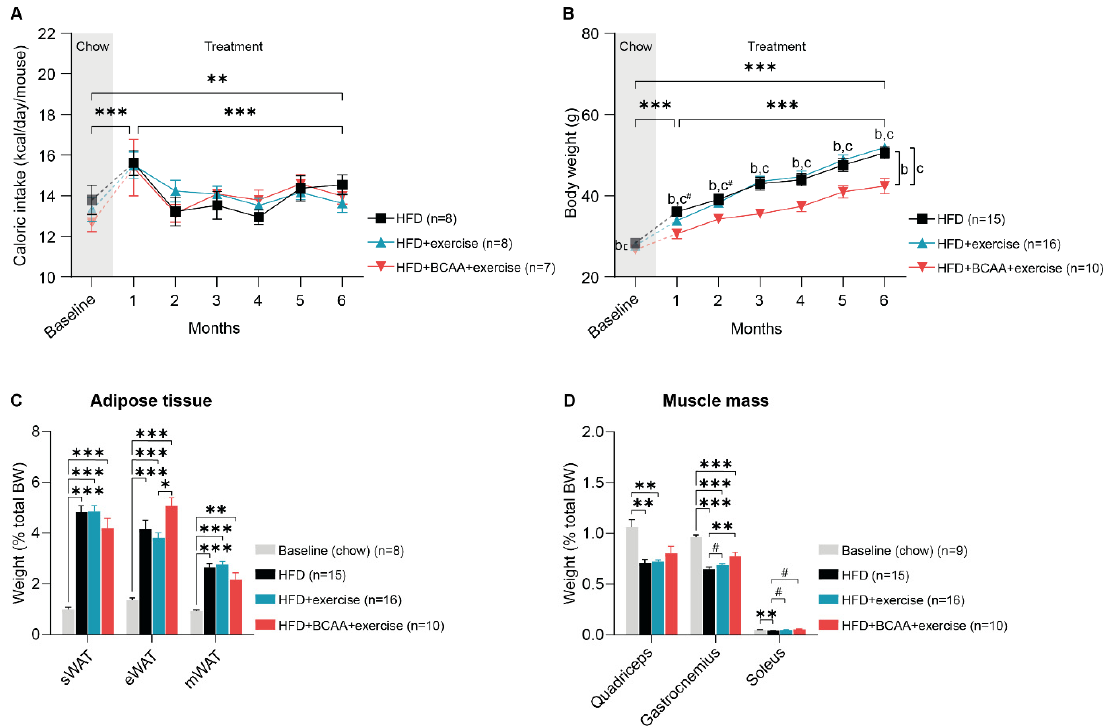
Figure 2. Body weight, caloric intake, fat depots, and muscle mass. The impact of exercise (HFD + exercise) and exercise combined with BCAA supplementation (HFD + BCAA + exercise) on ( A ) body weight, ( B ) caloric intake, ( C ) white adipose tissue depots (subcutaneous adipose tissue (sWAT), epididymal white adipose tissue (eWAT), and mesenteric white adipose tissue (mWAT)), and ( D ) muscle weight (quadriceps, gastrocnemius, and soleus) expressed as a percentage of total body weight (BW). High-fat diet (HFD), branched-chain amino acids (BCAA). Data are presented as mean ± SEM. * p < 0.05, ** p < 0.01, *** p < 0.001, # 0.05 < p < 0.08 (trend); b: significant difference HFD vs. HFD + BCAA + exercise group; c: significant difference HFD + exercise vs. HFD + BCAA + exercise group.